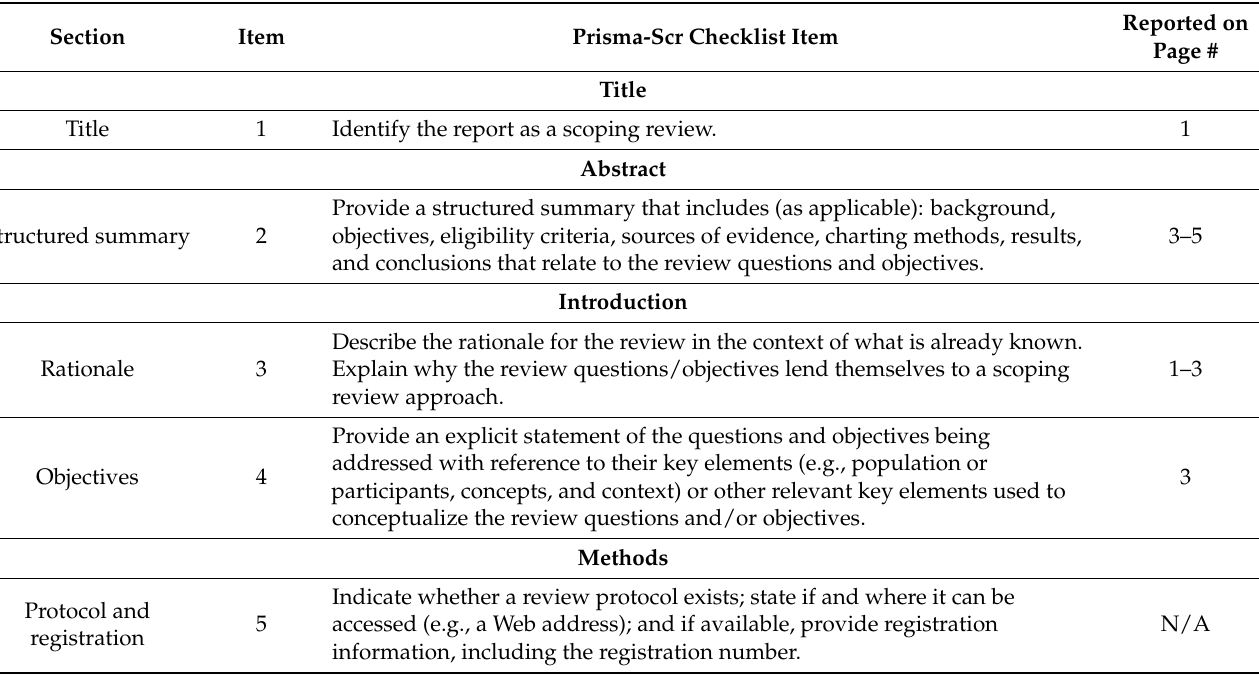
Table 1. Preferred Reporting Items for Systematic reviews and Meta-Analyses extension for Scoping Reviews (PRISMA-ScR)